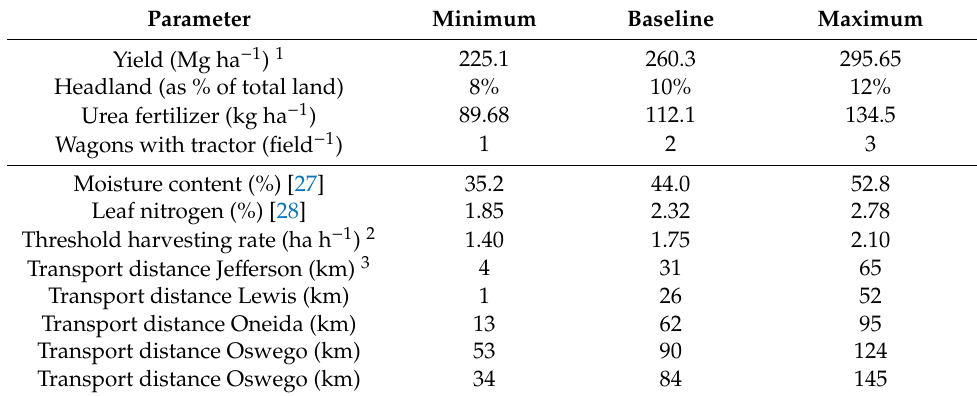
Table 1. Modeled input parameters for baseline LCA and sensitivity